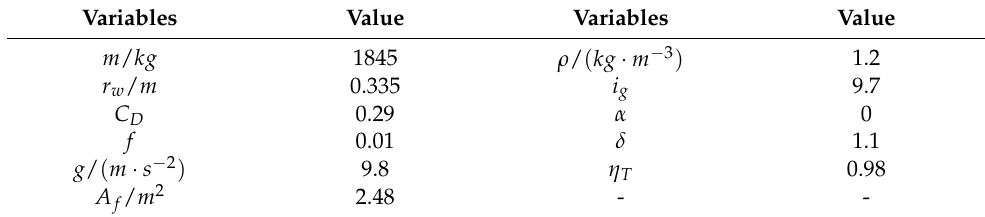
Table 3. Vehicle model